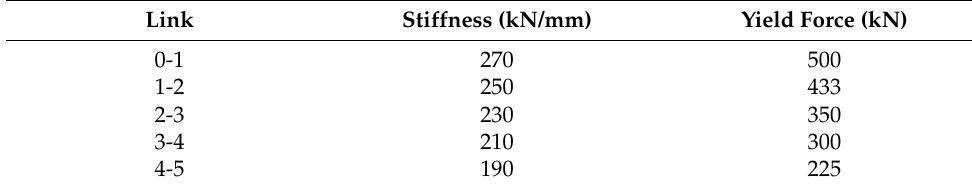
Table 2. Definition of the nonlinear link properties of the simulated mass-spring model.